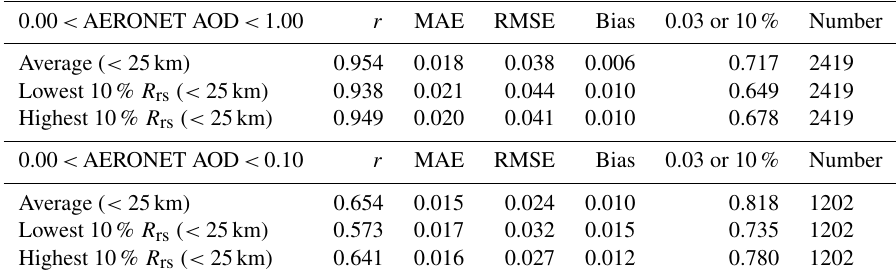
Table 1. Statistics of MISR 558nm (Green) AOD retrievals as compared to AERONET. 0.00 < AERONET AOD < 1.00